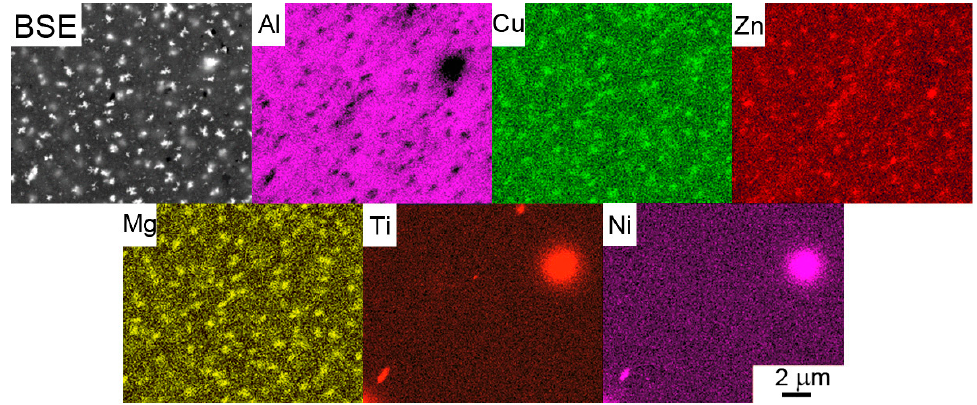
Figure 10. Element distribution in the Al7075Zr_MC compact. BSE and the corresponding SEM-EDS maps.